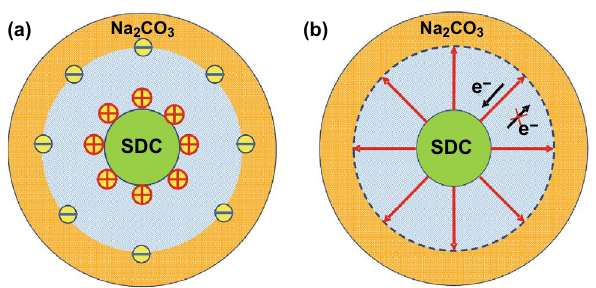
Fig. 10 Built‑in‑field (BIF) effect between SDC (samarium‑doped ceria) and Na 2 CO